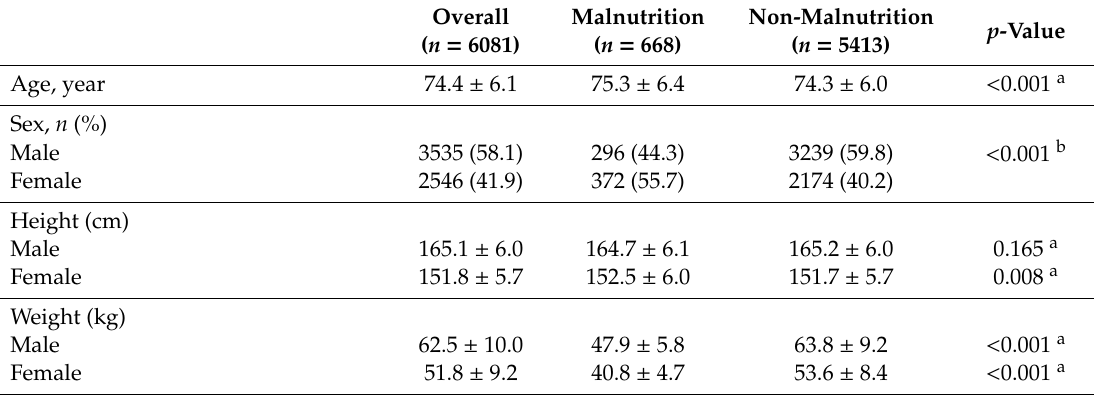
Table 1. Characteristics of subjects whose data were analyzed.